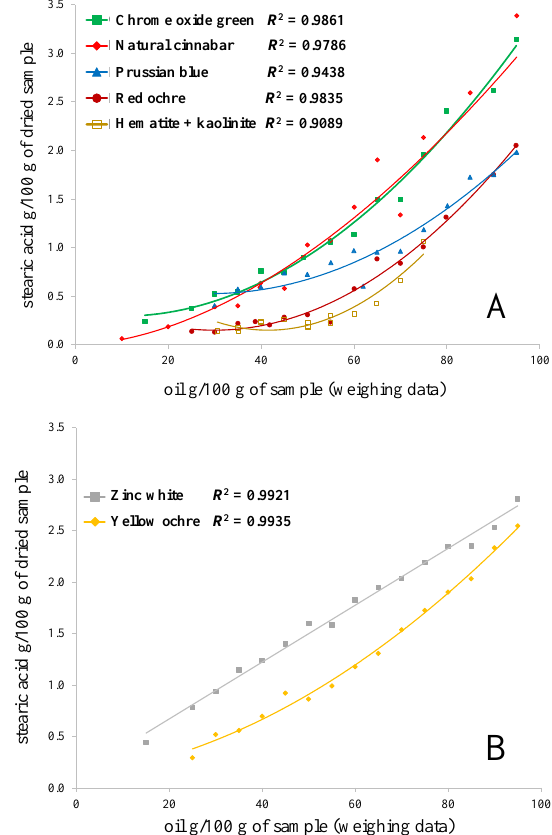
Figure 3. Correlations between stearic acid absolute quantity (g/100 g) vs. oil content (g/100 g) in the weighted sample. ( A ) chrome oxide green, natural cinnabar, Prussian blue, red ochre, and hematite + kaolinite mixtures with linseed oil. ( B ) zinc white and yellow ochre mixtures with linseed oil. The name of the pigment represents the studied pigment and linseed oil mixture. In theory, if the concentration of a pigment does not influence the drying extent of linseed oil, then the correlation should be linear. The correlation in the case of chrome oxide green, natural cinnabar, red ochre, hematite + kaolinite, and Prussian blue are far from linear. This demonstrates that the higher the pigment concentration in these paint samples, the more stearic acid has evaporated from the paint. For zinc white and yellow ochre paints, the curves are the closest to a linear function. In the yellow ochre + linseed oil case, the reason for a curve closer to a linear function could be the fact that the samples were aged two months less, without artificially increased relative humidity, and the amount of the prepared paints was three times higher than for the paint samples pre- sented in subfigure A in Figure 3. For example, when looking at the absolute values in Table 3 and comparing the stearic acid quantities for 80 g of linseed oil per 100 g of sample to 40 g, it is evident that the decrease has been around 2.7 times, not 2. Therefore, it can be